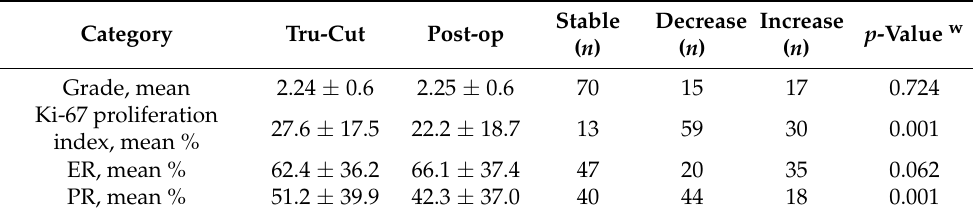
Table 7. Tumor grade, Ki-67 proliferation index, and ER and PR expression levels before and after NACTx. Category Tru-Cut